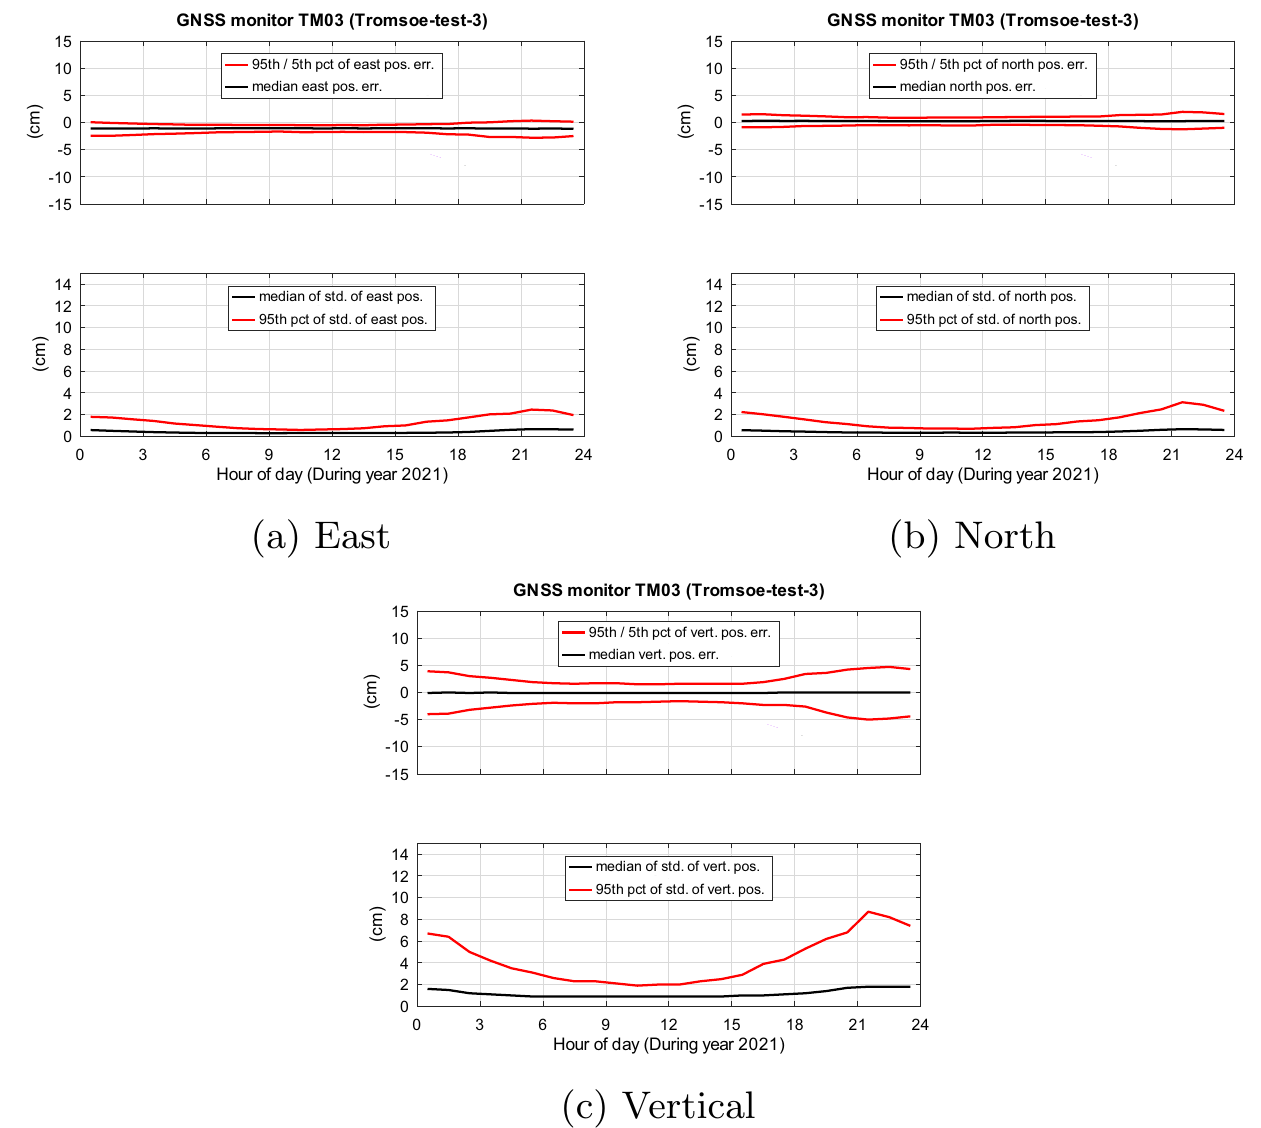
Bottom panel of each subplot: Median and 95th percentile of posi- tion standard